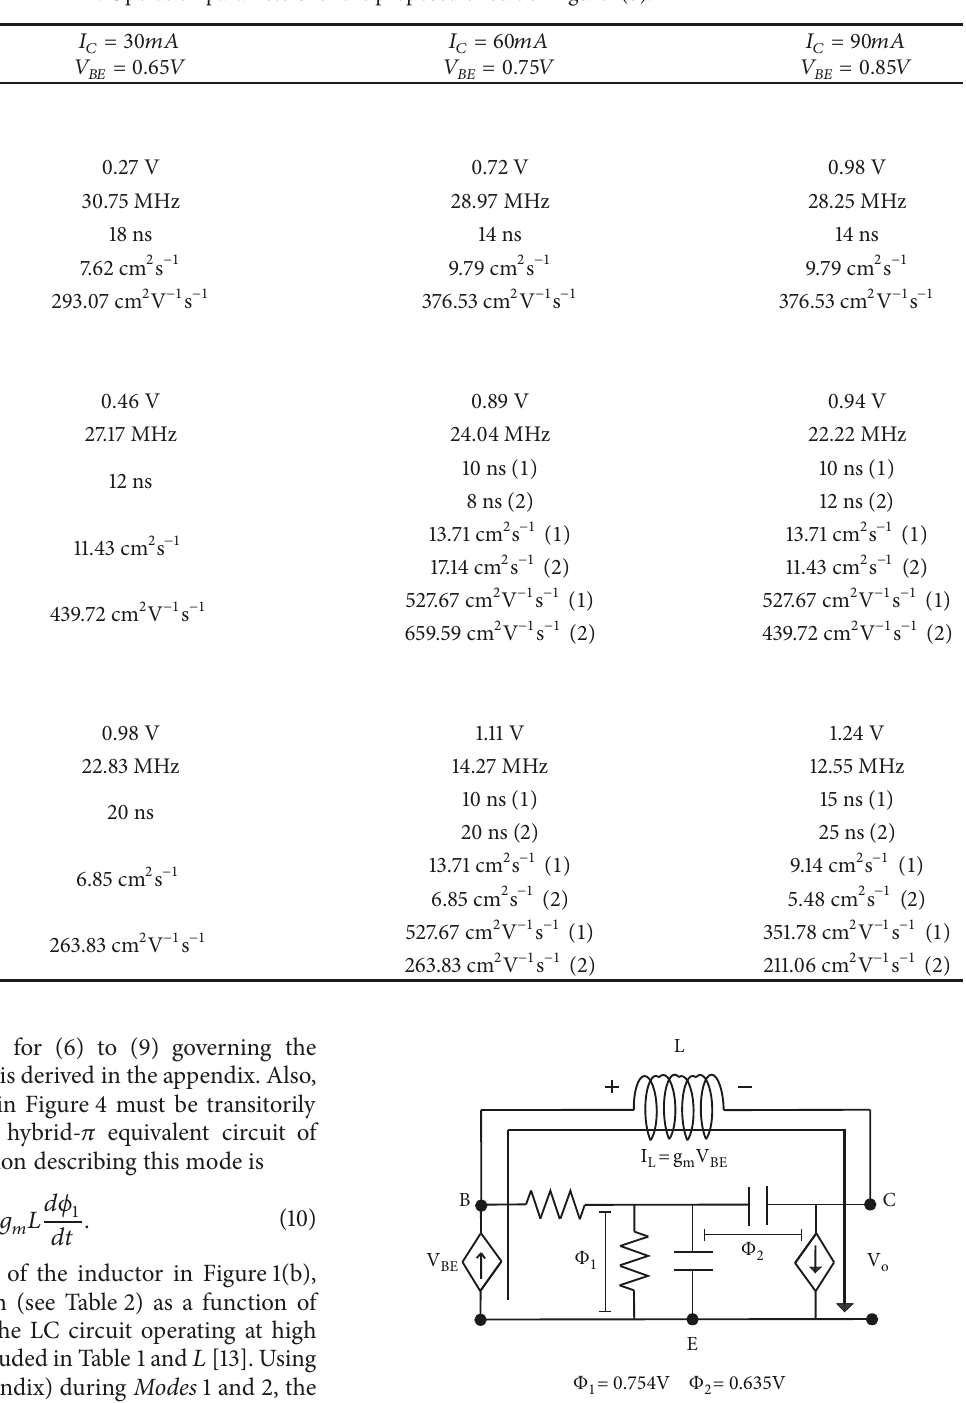
Table 2: Operation parameters for the proposed circuit of Figure 1(b).